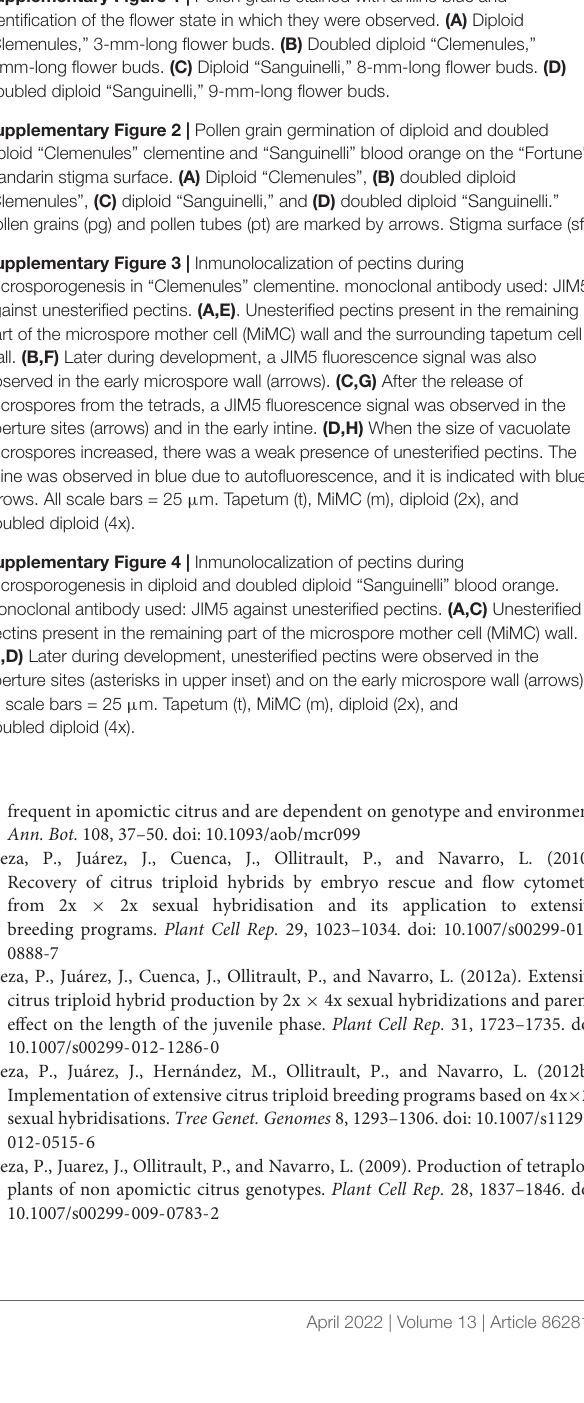
Supplementary Figure 3 | Inmunolocalization of pectins during microsporogenesis in “Clemenules” clementine. monoclonal antibody used: JIM5 against unesterified pectins. (A,E) . Unesterified pectins present in the remaining part of the microspore mother cell (MiMC) wall and the surrounding tapetum cell